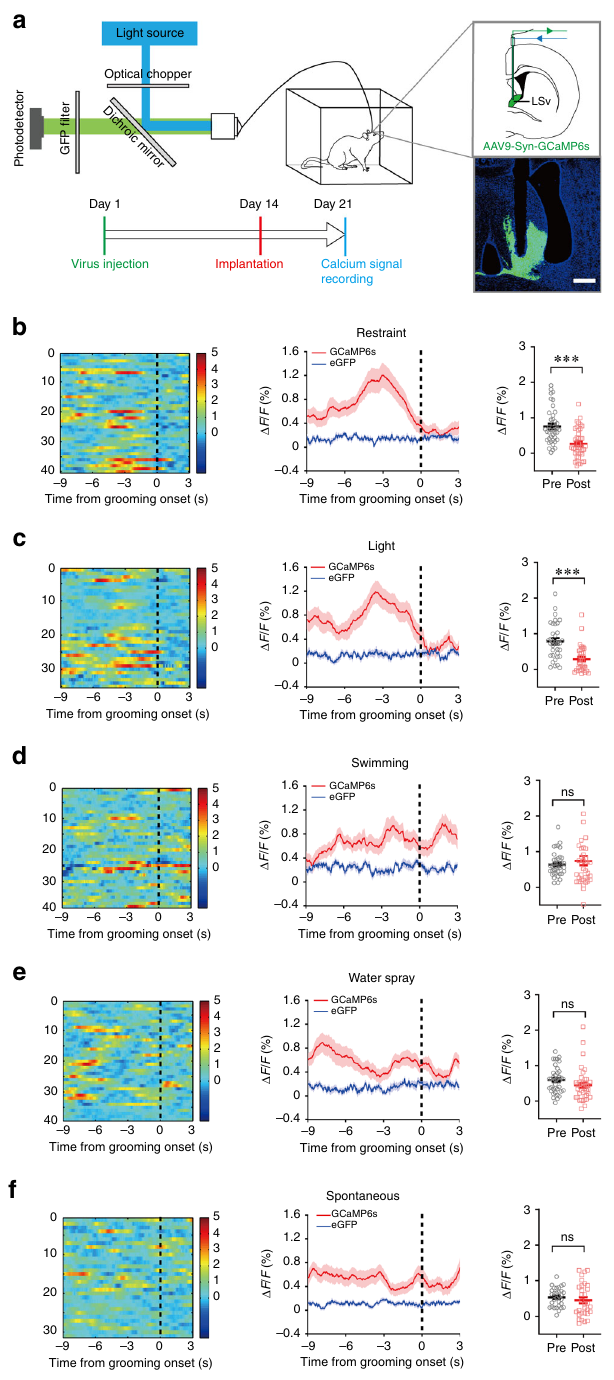
population dynamics of LSv neurons in freely behaving rats in the different grooming models by fi bre photometry based on the GCaMP6s reporter (Fig. 8a). After stress induction, the calcium activities of the neurons were monitored and aligned to the start of detected grooming bouts. In the body restraint (Fig. 8b) and light exposure model (Fig. 8c), we detected on average a clear rise in calcium signals of LSv neurons shortly before the start of a grooming event. Signi fi cant differences in Δ F / F in the pre- grooming and post-grooming periods were found (Fig. 8b, c). In contrast, no discernible changes in calcium signals were found in the swimming (Fig. 8d) and water spray (Fig. 8e) models as well as in spontaneous grooming (Fig. 8f). In addition, the fl uorescent